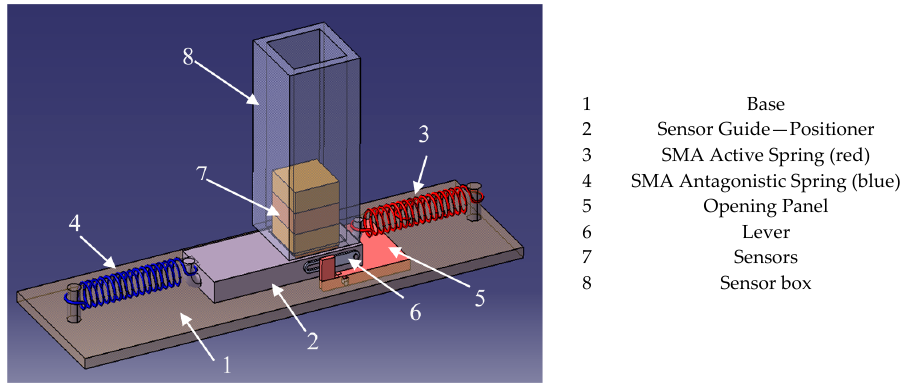
Figure 3. CAD of the environmental sensor spreader (ESS) and its main elements.